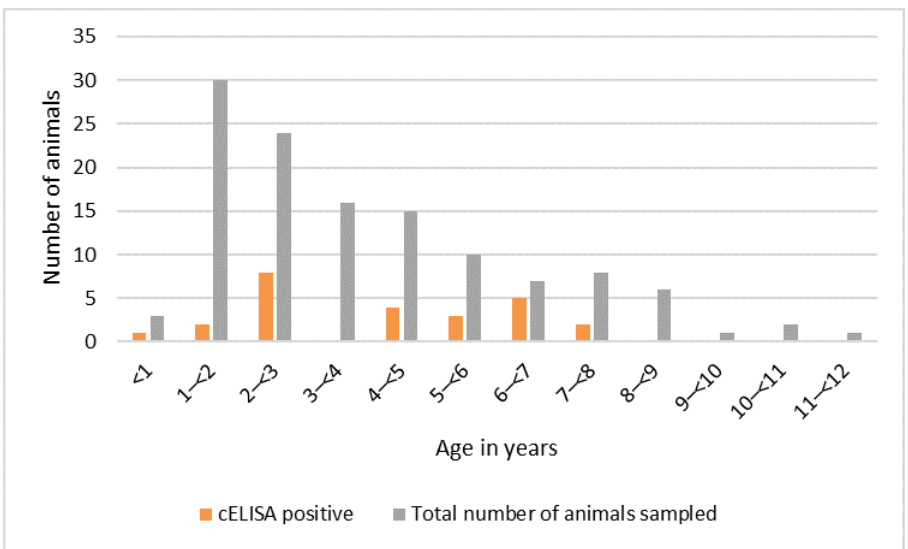
Figure 6. Peste des petits ruminants virus serology results by age, Kenya and Tanzania purposive wild animal sampling 2015 – 2016 (n = 123). wild animal sampling 2015–2016 (n =